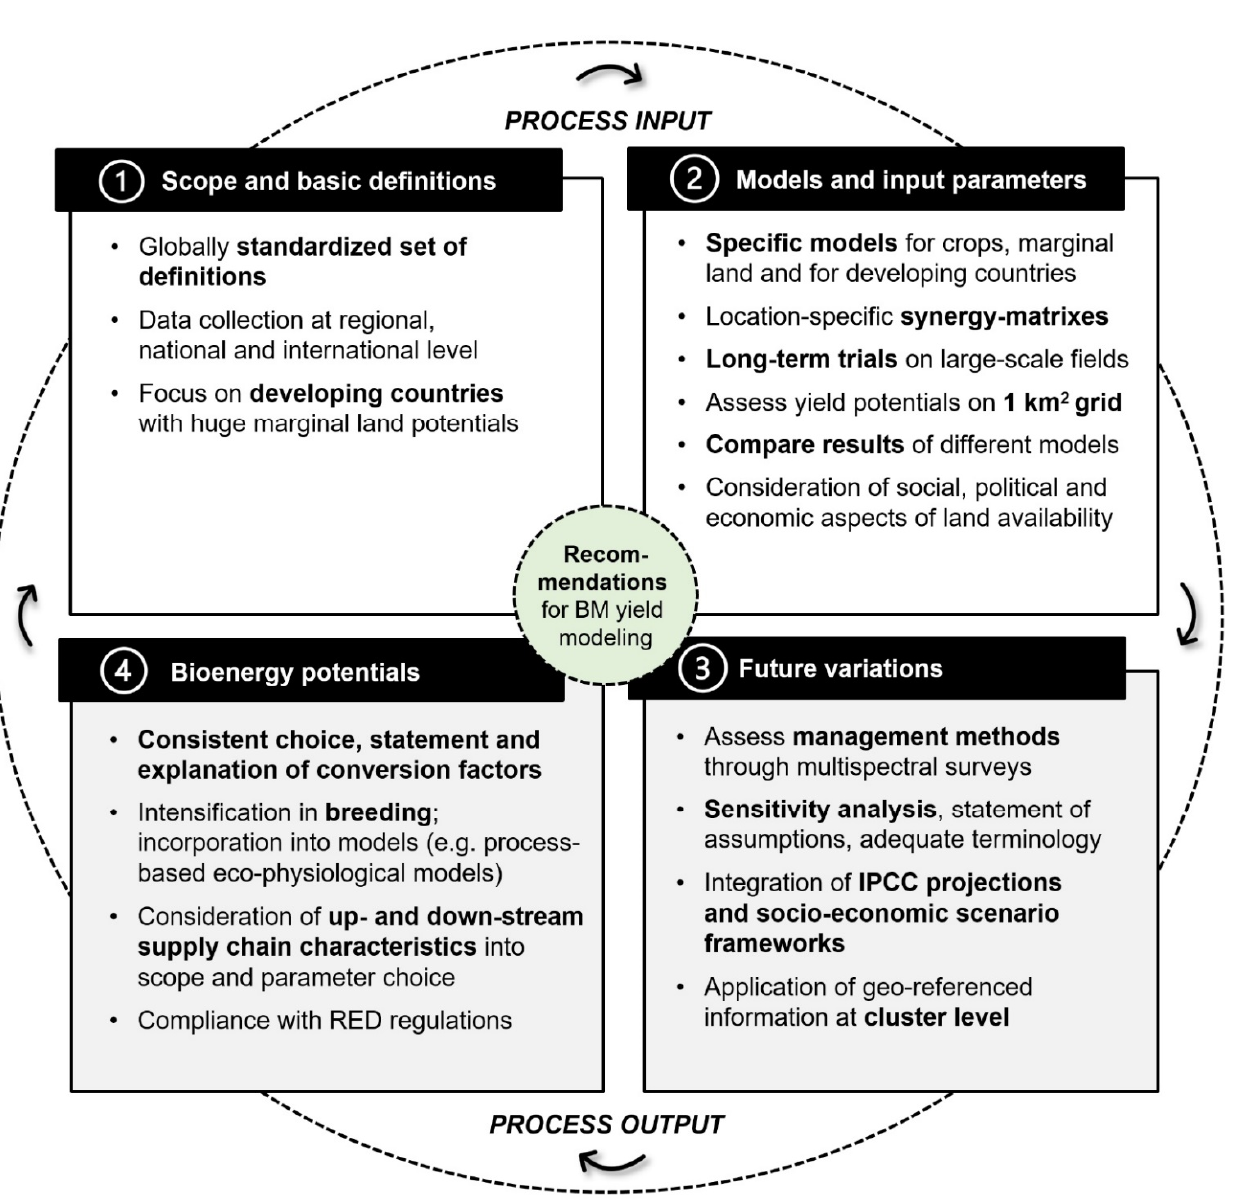
Figure 3. Overview on the most relevant recommendations and milestones for future biomass (BM) yield modeling.